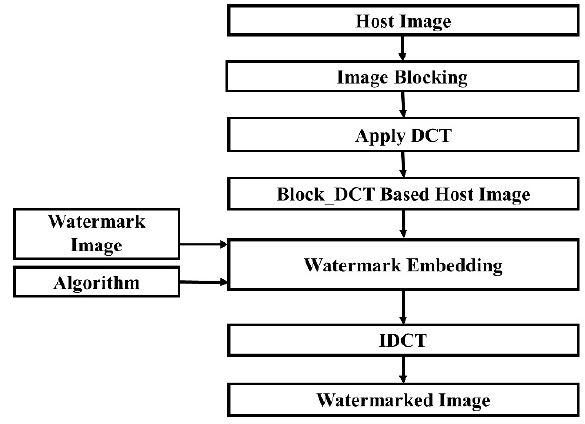
Figure 12. Watermark embedding in a block-based DCT domain.